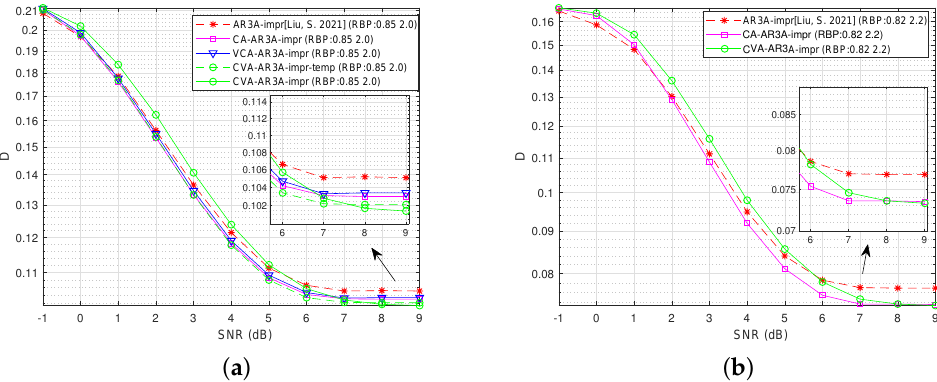
Figure 7. The performance of the optimized codes based on AR3A codes [11] for lossy compression over AWGN channels. ( a ) Code rate: 0.57 ( b ) Code rate: